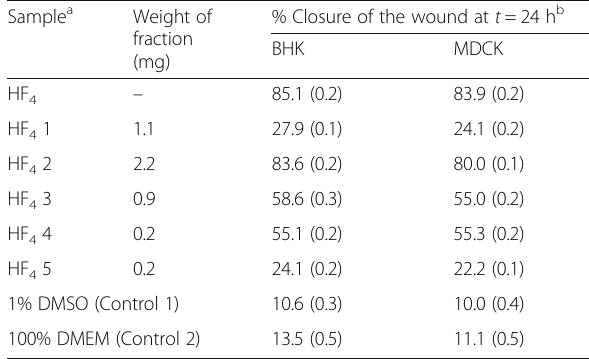
Table 2 Weights of sub fractions of fraction HF 4 of hexanes extract and percentage wound closure of those fractions at 24 h with two different cell lines Sample